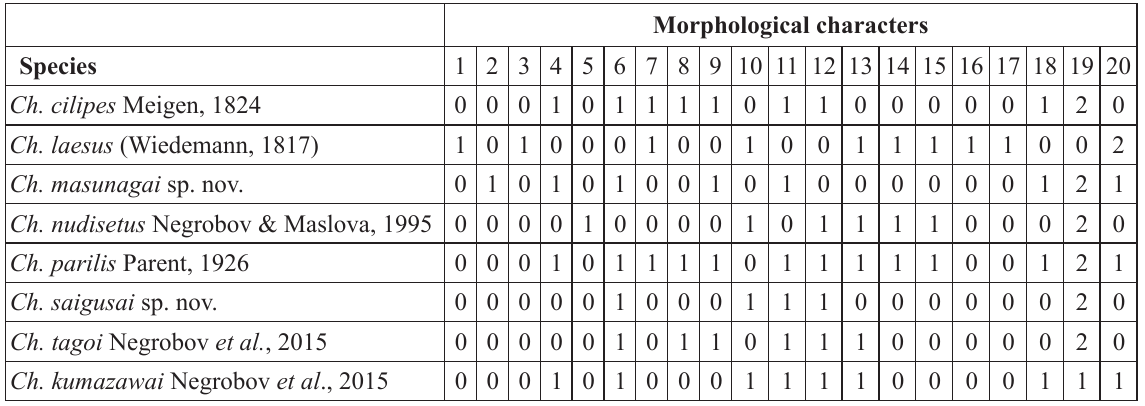
Table 1. Morphological characters matrix of the Chrysotus species from Japan.